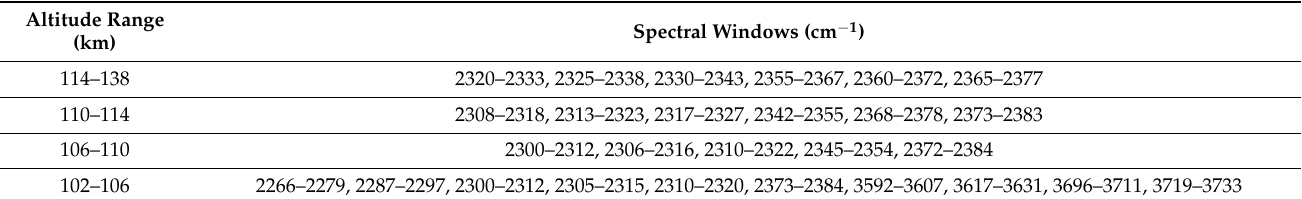
Table A1. Spectral windows employed in the determination of Doppler shifts from ACE-FTS measurements in the determination of line-of-sight